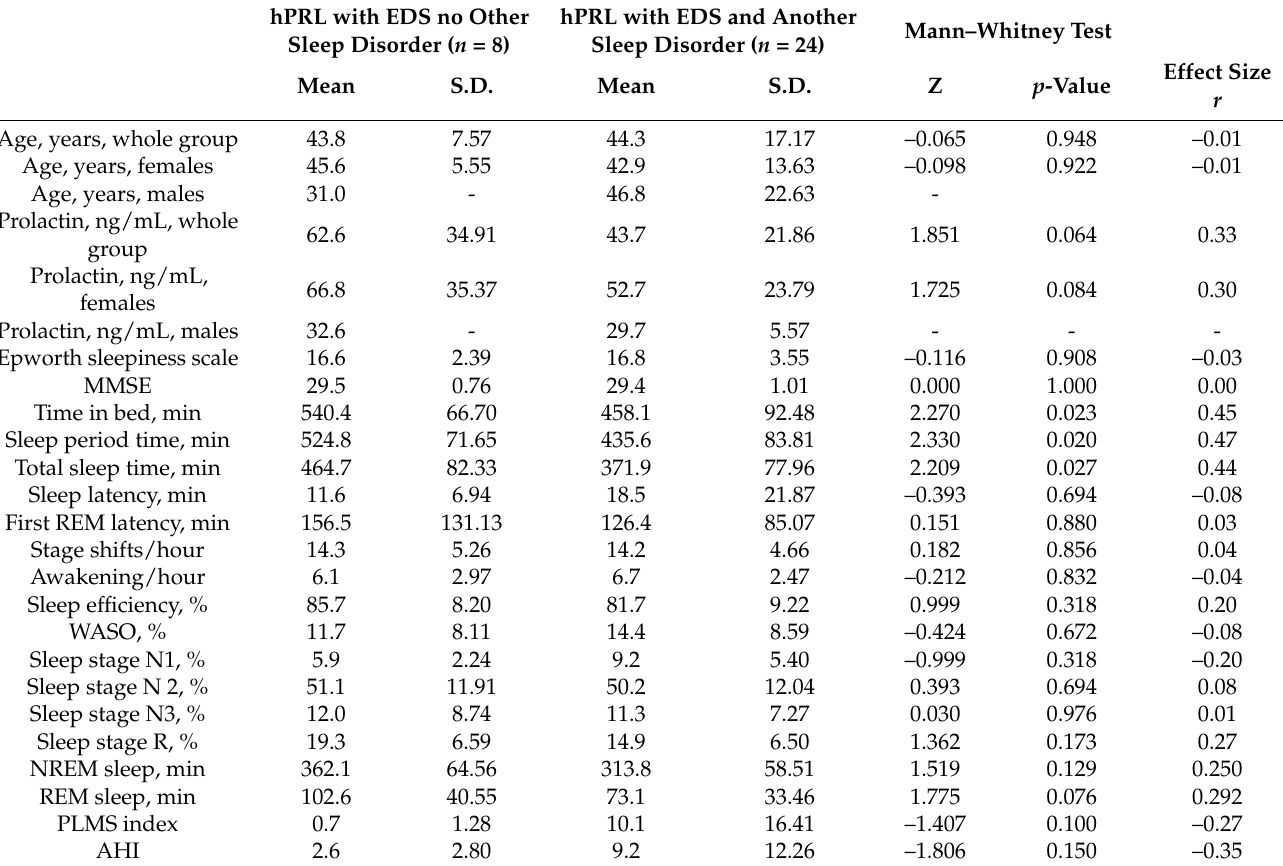
Table 3. Differences between the eight high prolactin (hPRL) patients with excessive daytime sleepiness (EDS), but without another sleep disorders and hPRL patients with a complaint of EDS associated to another sleep